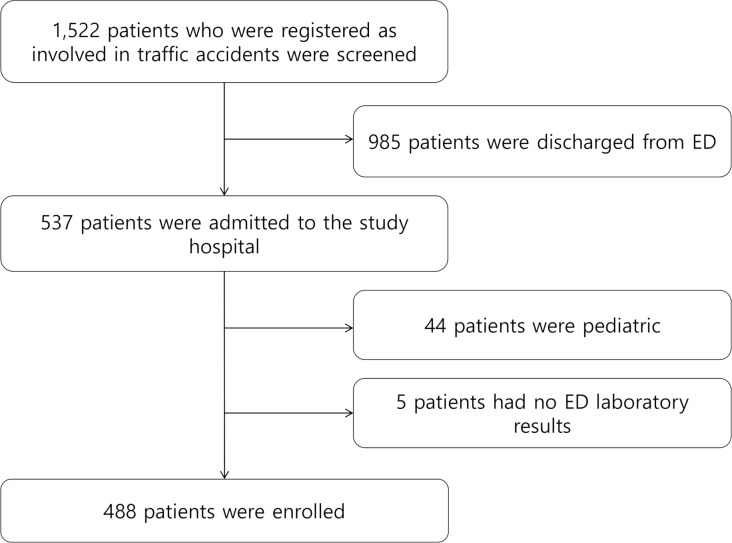
The Standards for the Reporting of Diagnostic Accuracy flow diagram for the study.